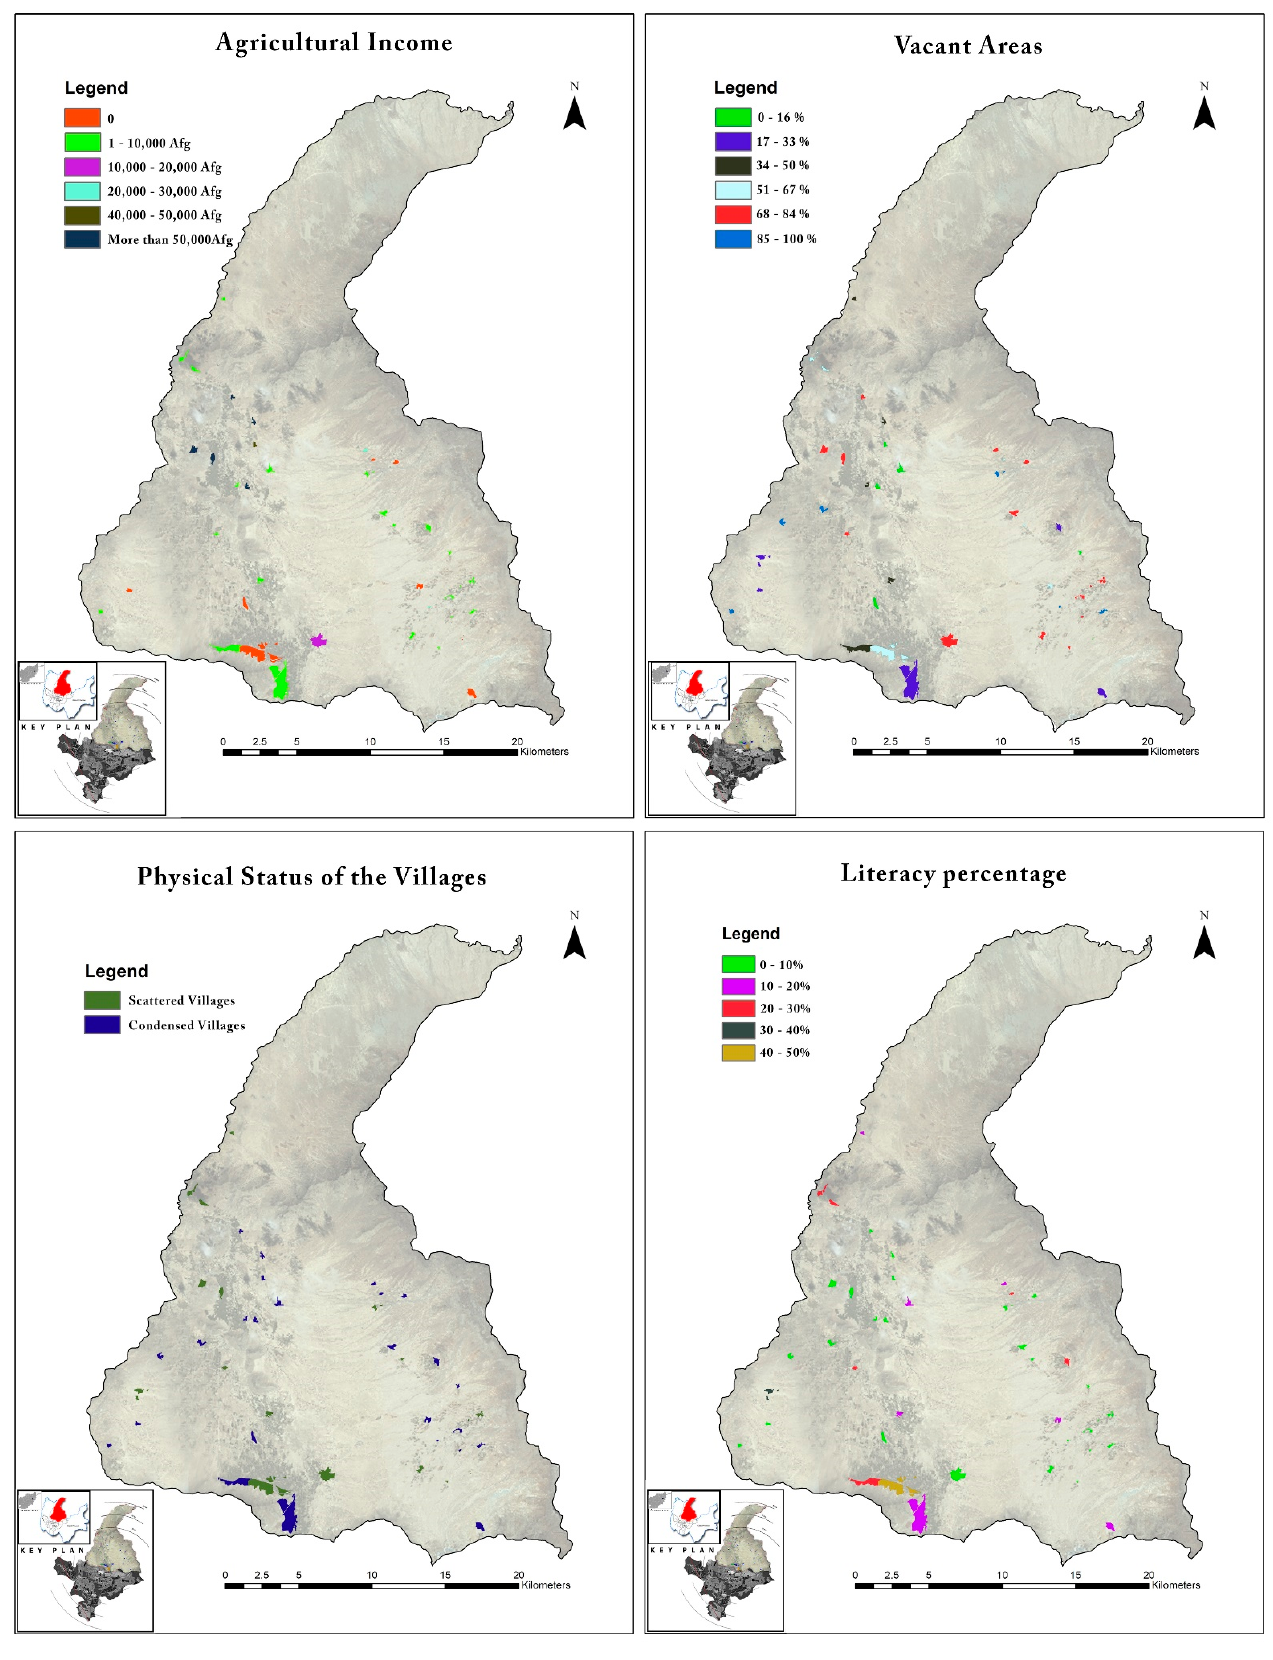
Figure 11. Parameters with their sub-indexes.